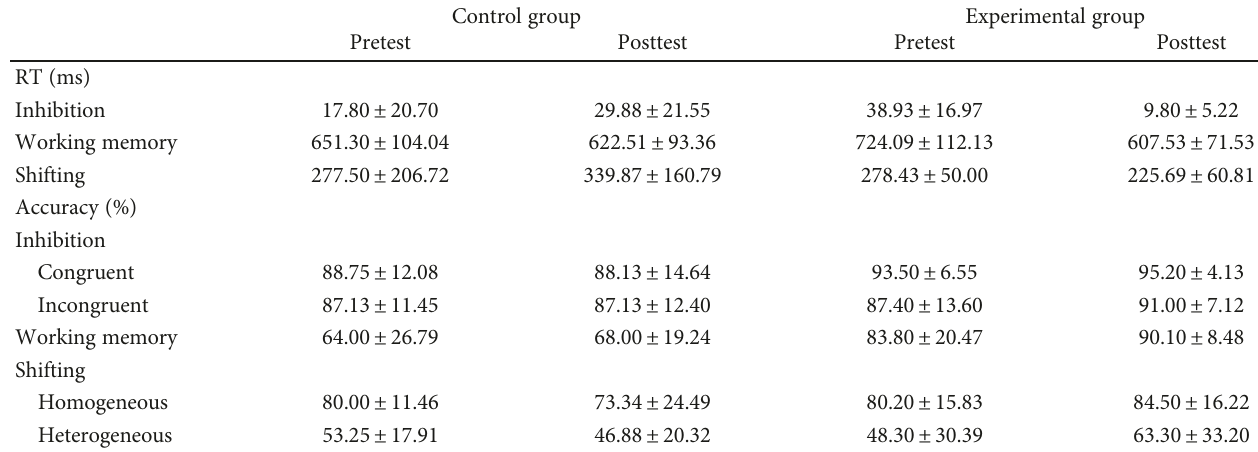
Table 2: Performance for three fundamental aspects of executive function ( M ± SD